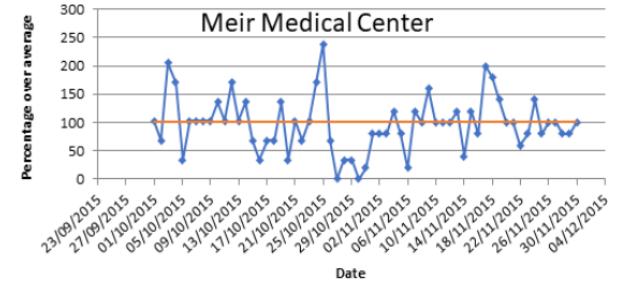
Figure 8. Two months of ER presentations of patients with respi- ratory problems at the Meir Medical Center in Kfar Saba, central Israel (for the period 1 October to 30 November 2015). The 25 Oc- tober record shows a 250% increase in a single